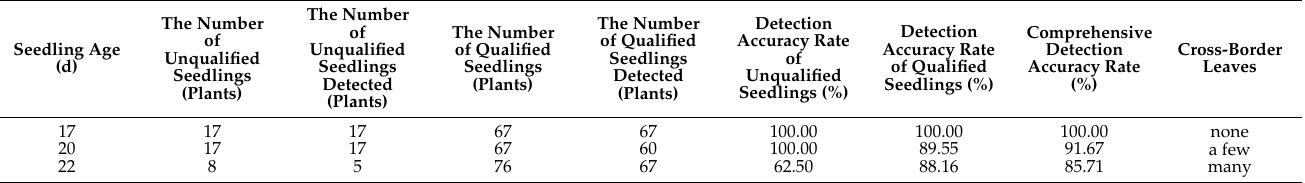
Table 2. Statistics of detection